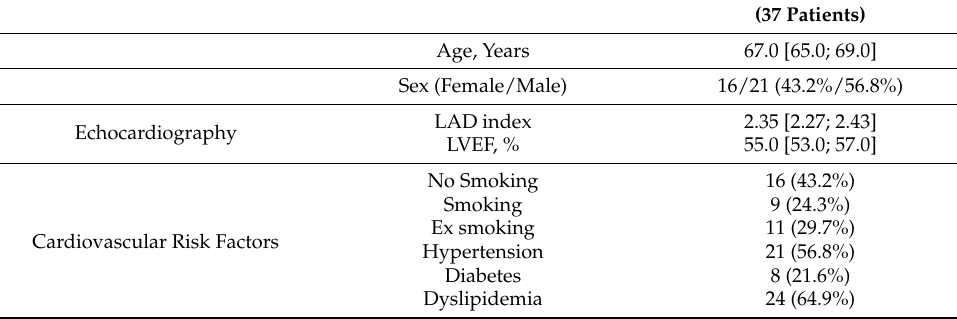
Table 1. Clinical Characteristics of the Study